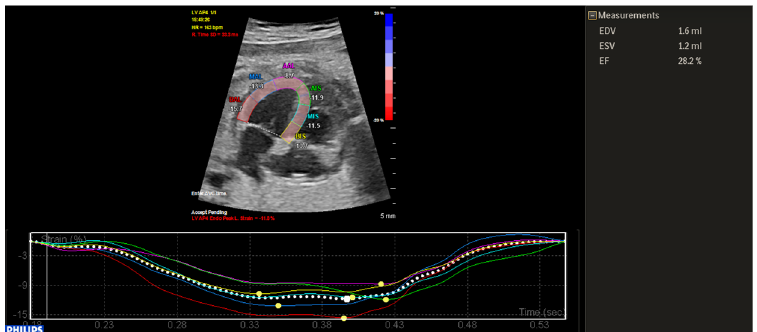
Figure 2. Fetal speckle tracking showing decreased ventricular function.